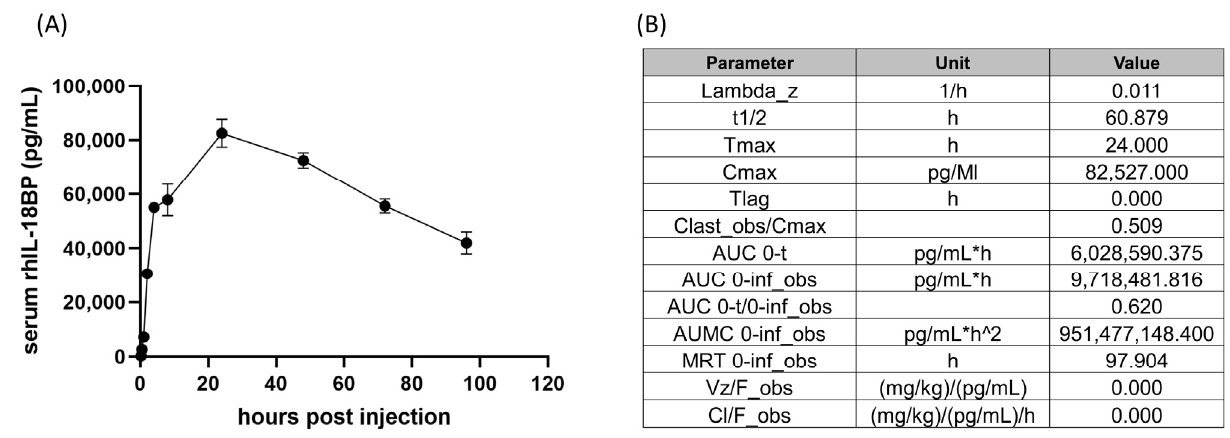
Figure 1. The PK study of rhIL-18BP in CD2F1 mice. rhIL-18BP was injected s.c into CD2F1 mice. Serum samples from 0.25, 0.5, 1, 2, 4, 8, 24, 48, 72, and 96 h after injection were used for rhIL-18BP quantification using ELISA. Pharmacokinetic parameters were determined using a Microsoft Excel add-in “PKSolver”. ( A ) Serum concentrations of rhIL-18BP at different time points after injection. ( B ) PK parameters generated from the PKSolver using data from ( A ).